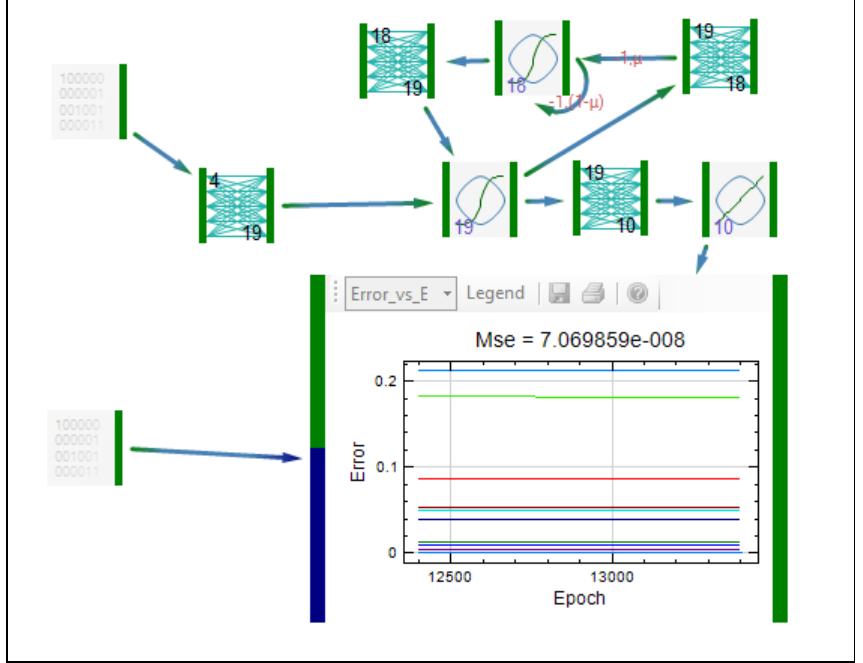
Figure 12. Representation of Elman dynamic neural network.